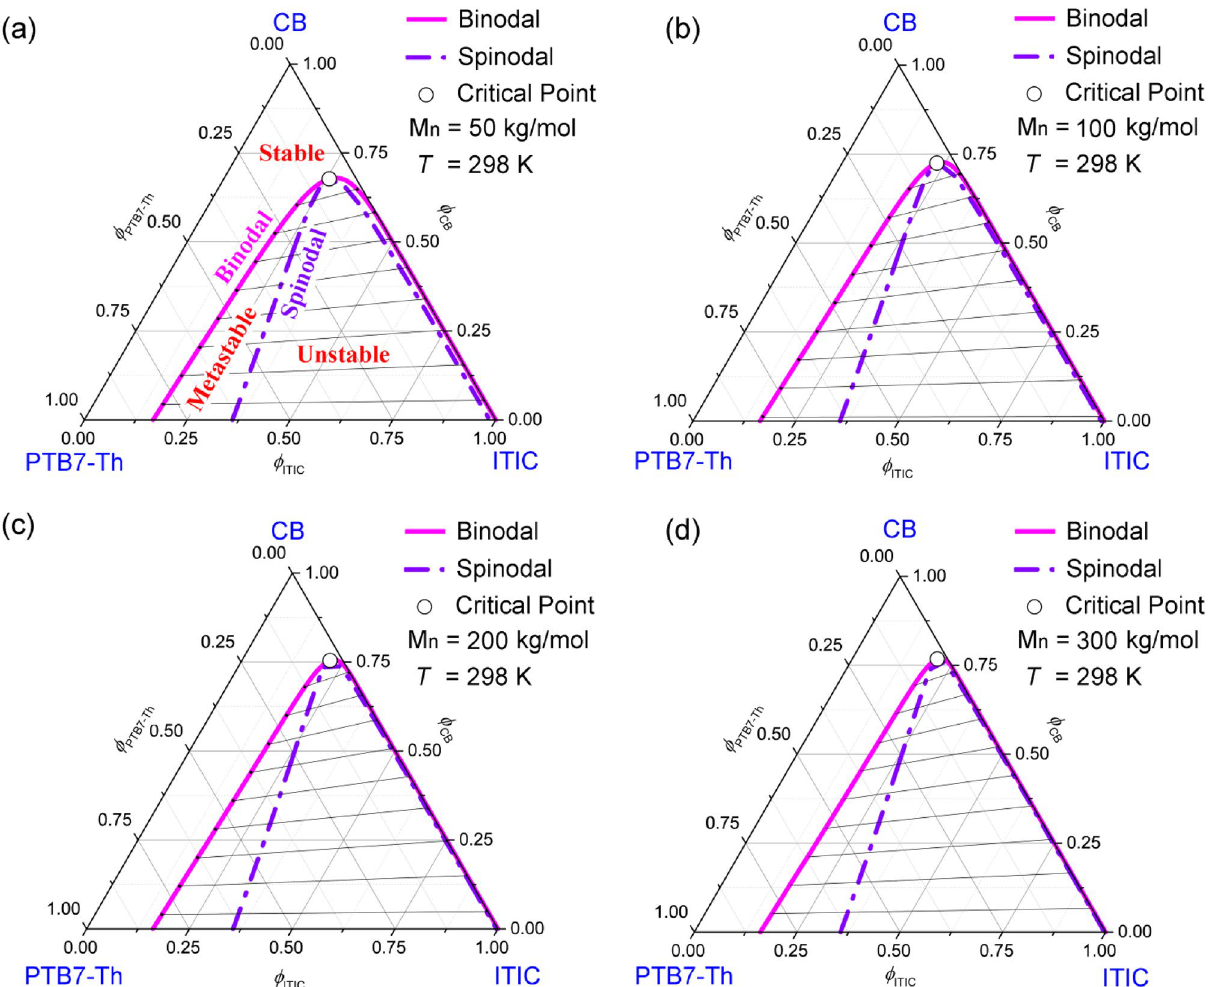
Figure 2. Phase diagrams for the ternary CB/PTB7-Th/ITIC system as a function of molecular weight at T = 298 K. χ 12 = 0.35 , χ 13 = 1.25 , and χ 23 = 1.41 . ( a ) M n = 50 kg/mol: s = 0.002332 and r = 0.087923. ( b ) M n = 100 kg/mol: s = 0.001127 and r = 0.087923. ( c ) M n = 200 kg/mol: s = 0.000583 and r = 0.087923. ( d ) M